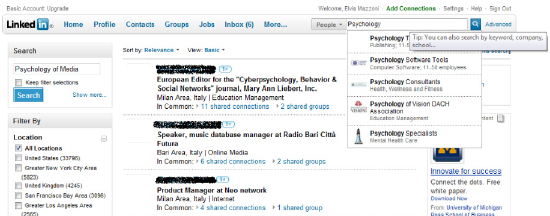
Figure 5. The search engine of the SNS LinkedIn and the results of a search (image taken from the original www.linkedin.com).